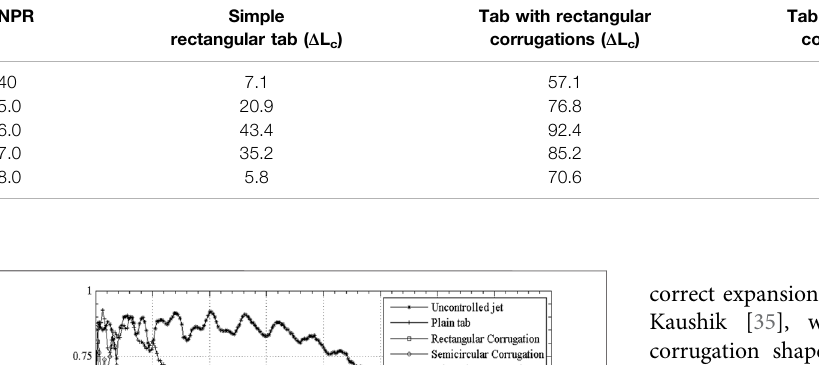
TABLE 1 | Percentage reduction in supersonic core length of the limiting corrugated tabs at different NPRs [12]. NPR Simple rectangular tab ( Δ L c )